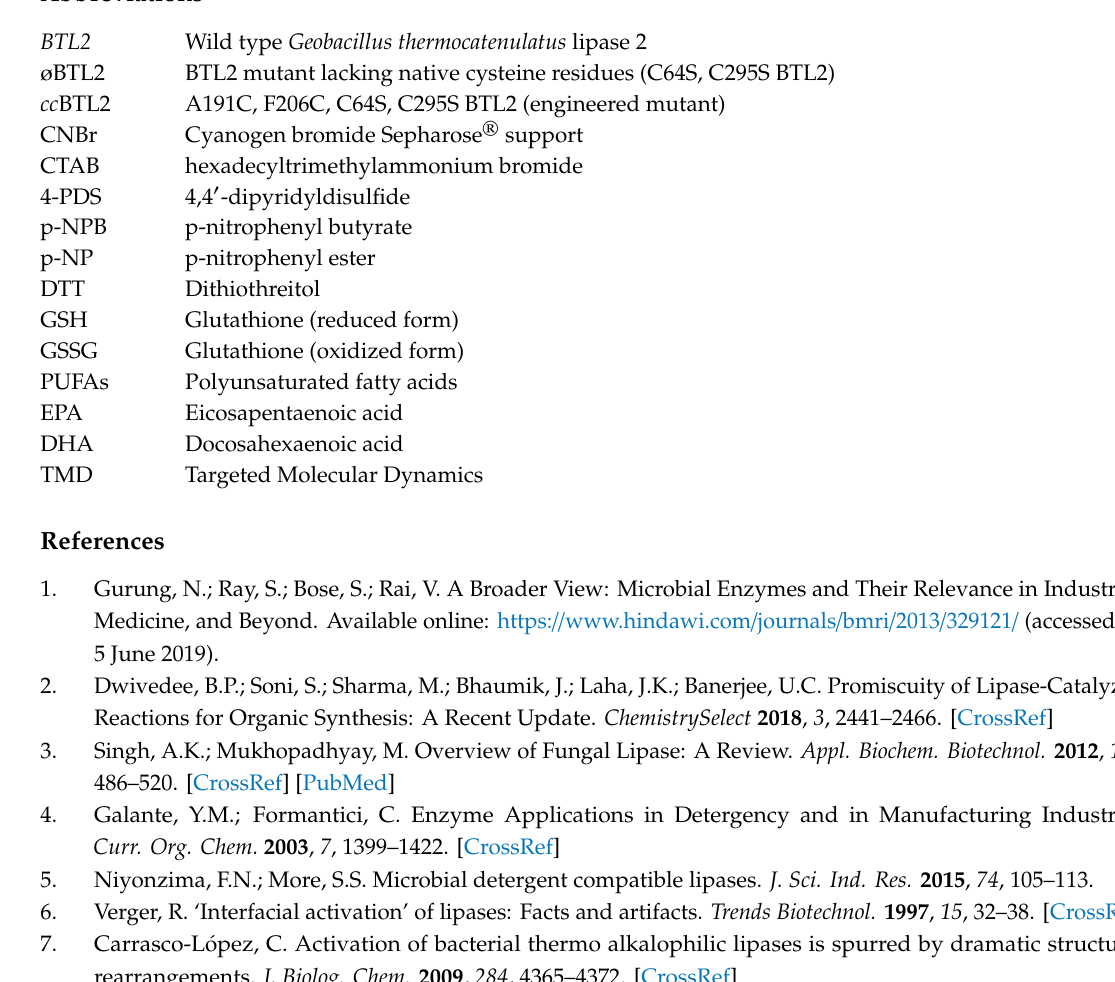
Figure S4: Reference volumes used to monitor the variation between the crystallographic structures of BTL2 and the cc BTL2